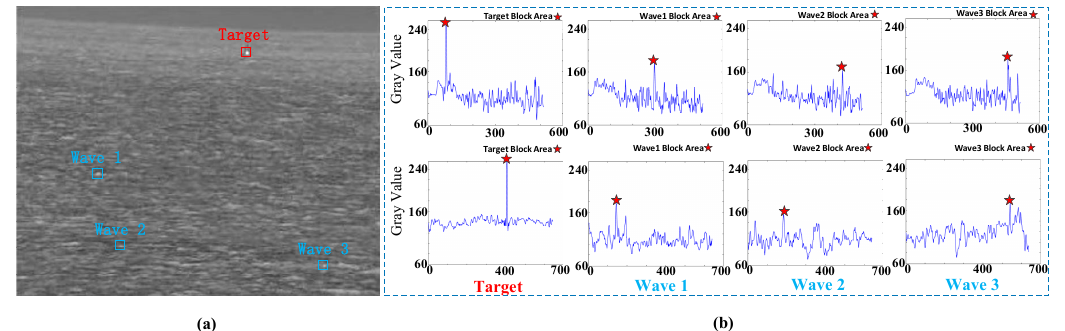
Figure 3. Gray distribution of waves and target. ( a ) denotes the original image (640 × 512), ( b ) denotes the gray distribution of waves and target in two directions, the upper part is the vertical directions and the lower part is the horizontal directions.